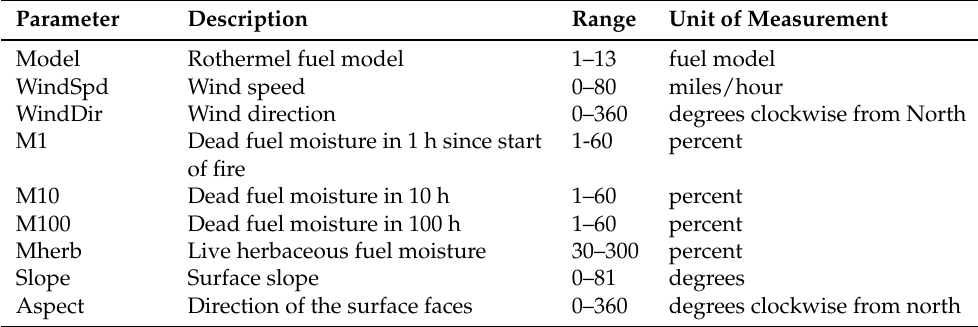
Table 1. Parameters used by the fireLib